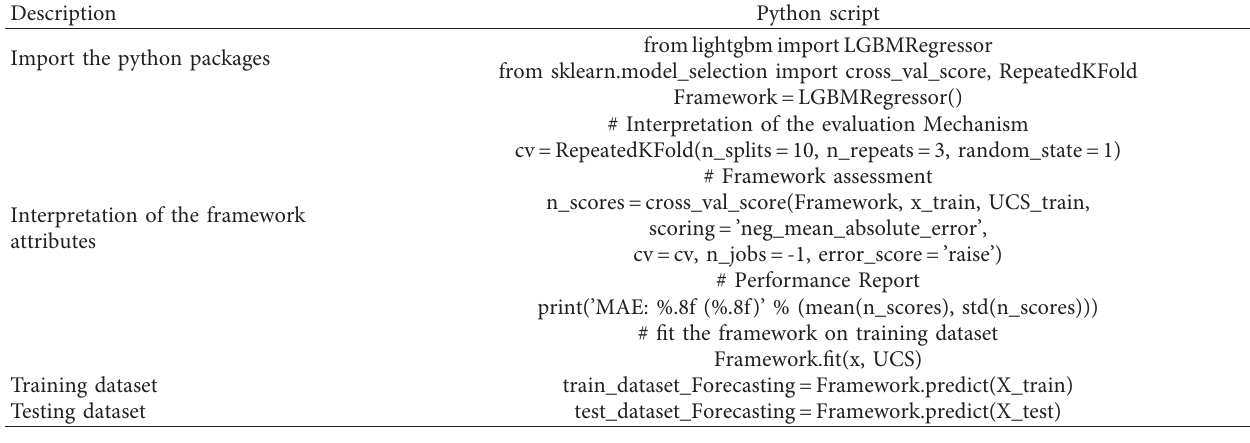
Table 6: Executing a lightgbm algorithm in python employing the lightgbm regressor.